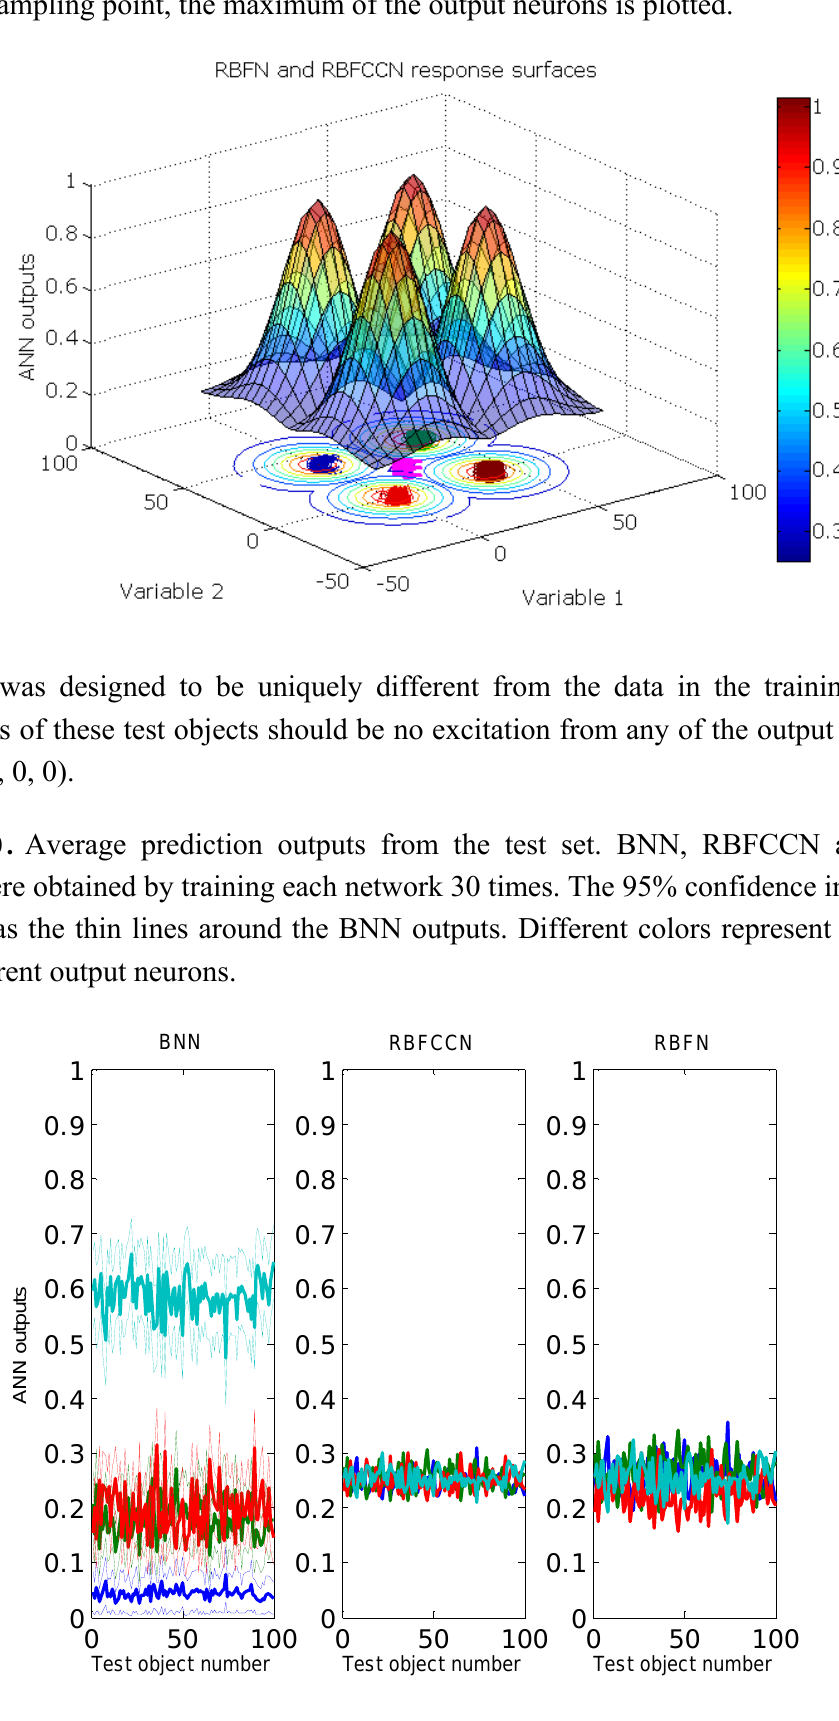
Figure 9. The RBFN and RBFCCN response surface of the synthetic novel class data set. For each sampling point, the maximum of the output neurons is plotted.